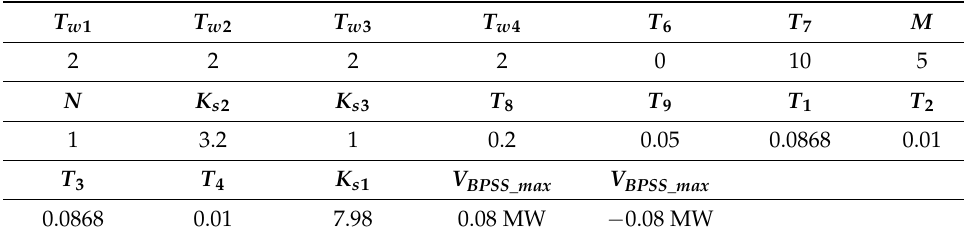
Figure 9. The bode diagram of ΔM e /Δω BPSS with and without compensation.